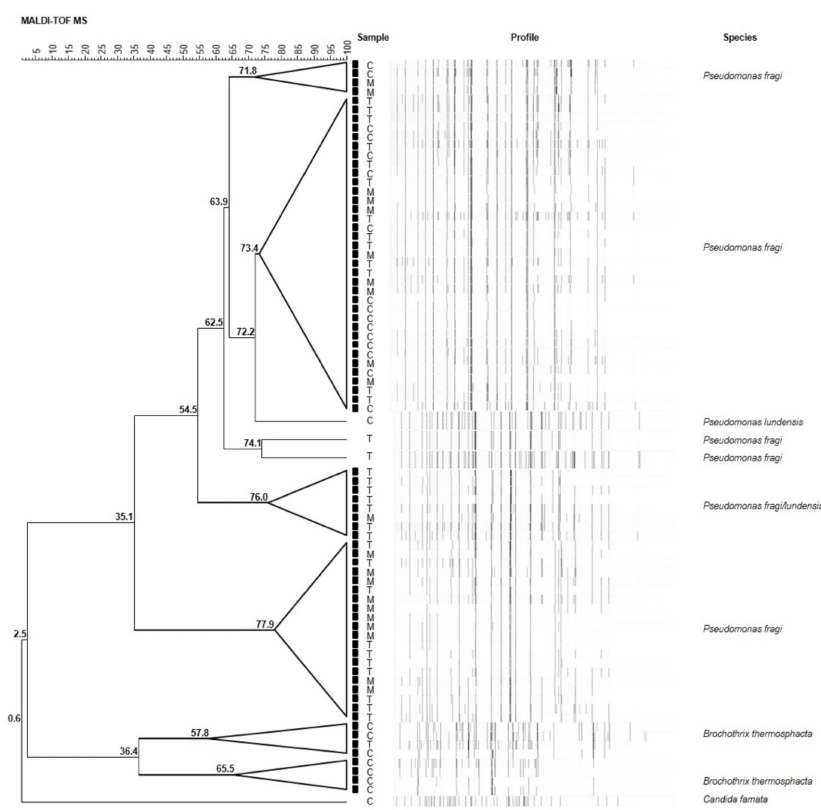
Figure 2. UPGMA (unweighted pair group method with arithmetic mean) dendrogram of the MALDI-TOF MS analyses of seventy-nine randomly selected meat samples. Node values indicate the average percentage of similarity based on MALDI-TOF MS profiles. The tree was made with BioNumerics version 5.1.